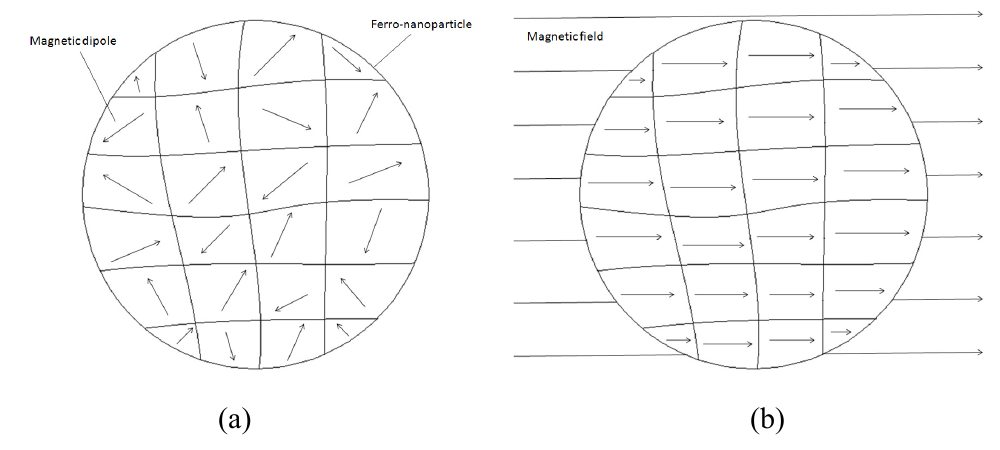
Figure 13. The microscopic view of a ferro-nanoparticle: (a) without a magnetic field; (b) with a magnetic